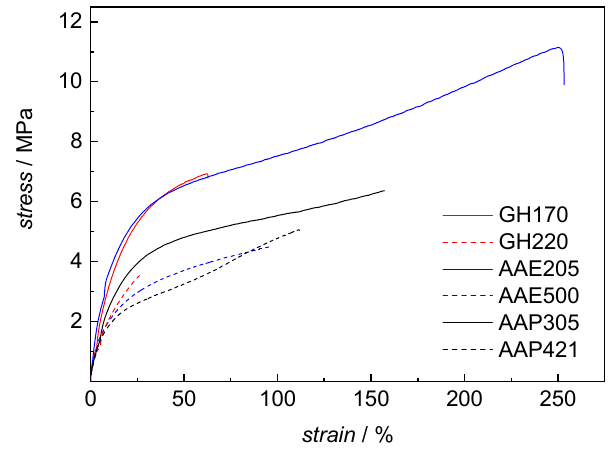
Figure 3. Tensile strength test of ETFE ‐ and PVDF ‐ based polymer membranes.